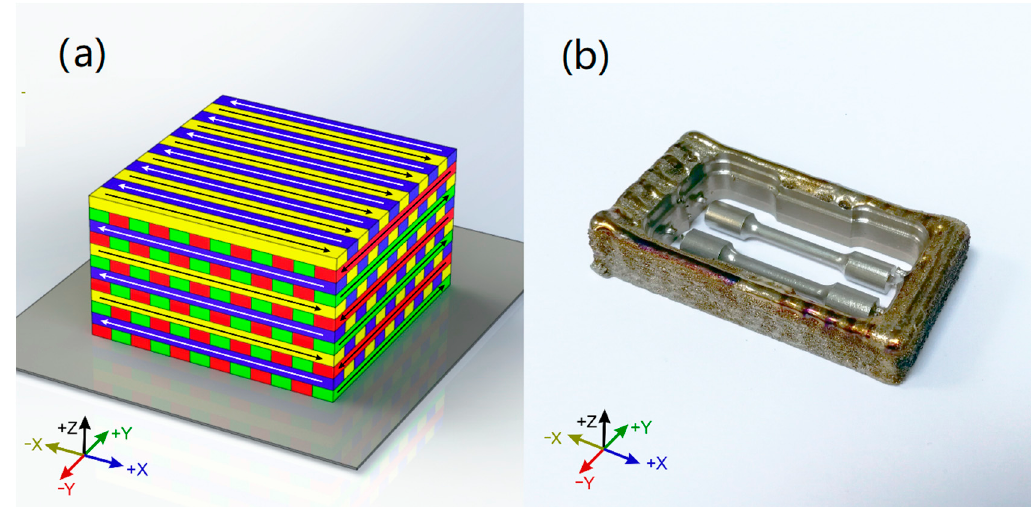
Figure 2. ( a ): Tridimensional representation of the scanning strategy of the LDED samples. ( b ): Specimens milled from the generated cuboids.